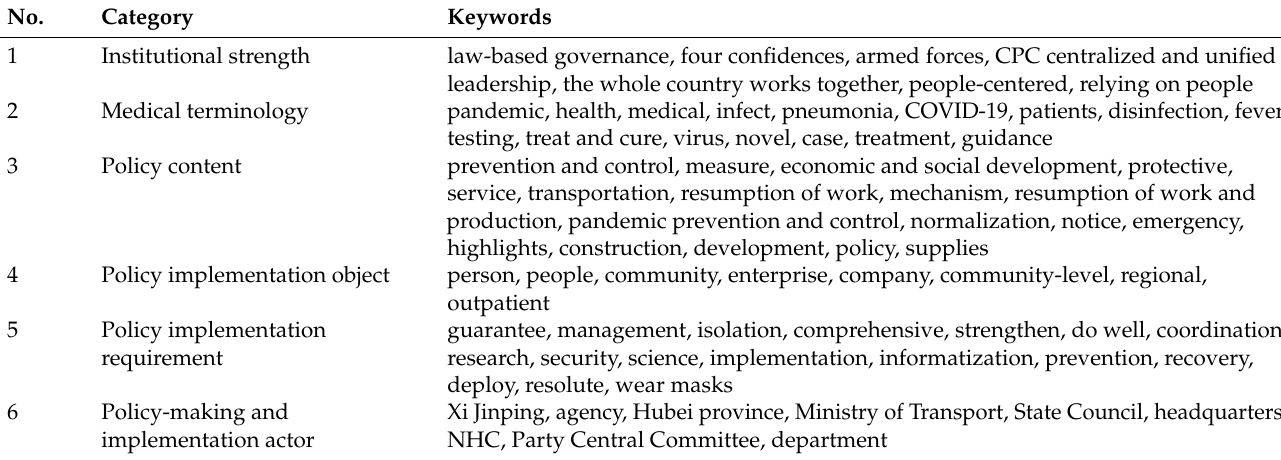
Table 3. Categorization of the top 75 high-frequency keywords in the prevention and control policies.